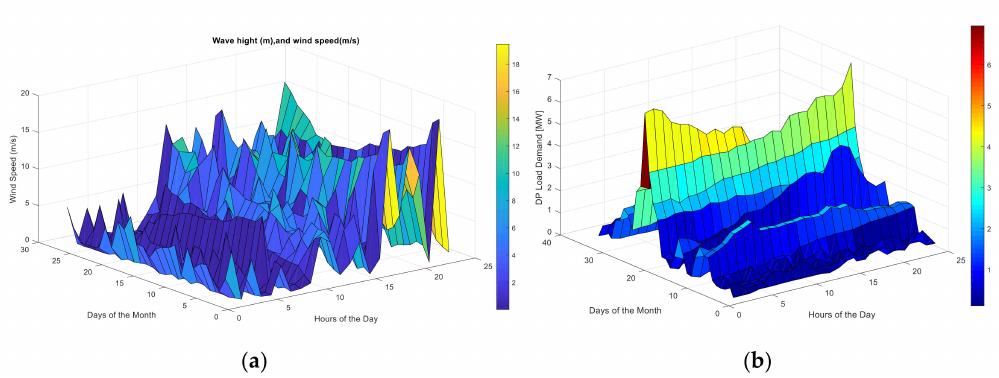
Figure 8. ( a ). Relationship model between wind speed and wave height as inputs for short terms load forecasting and ( b ) DP load profile for January